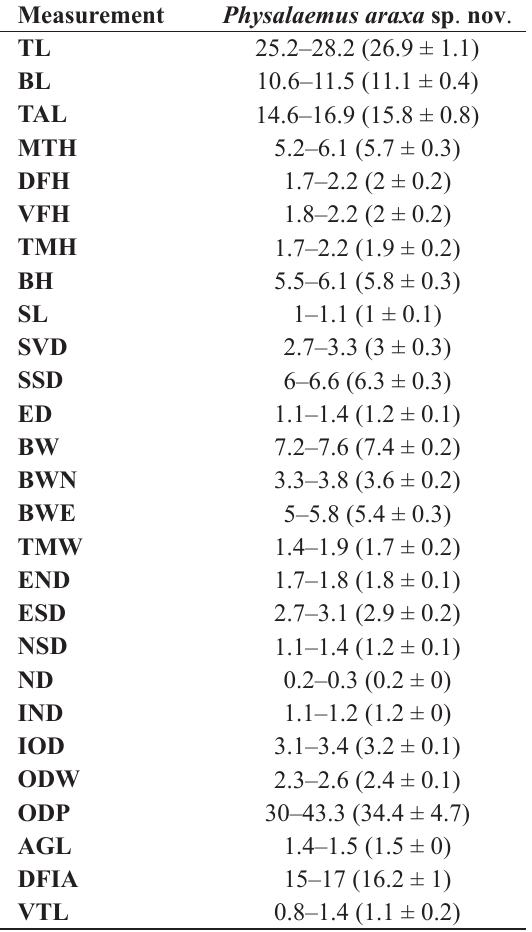
Table 4. Measurements (in mm) and angles of tadpoles of Physalaemus araxa sp. nov. (n = 9; ZUEC- AMP 24214) for the stages 37–38 (Gosner 1960). Data are presented as range (mean ± SD). See Material and methods for